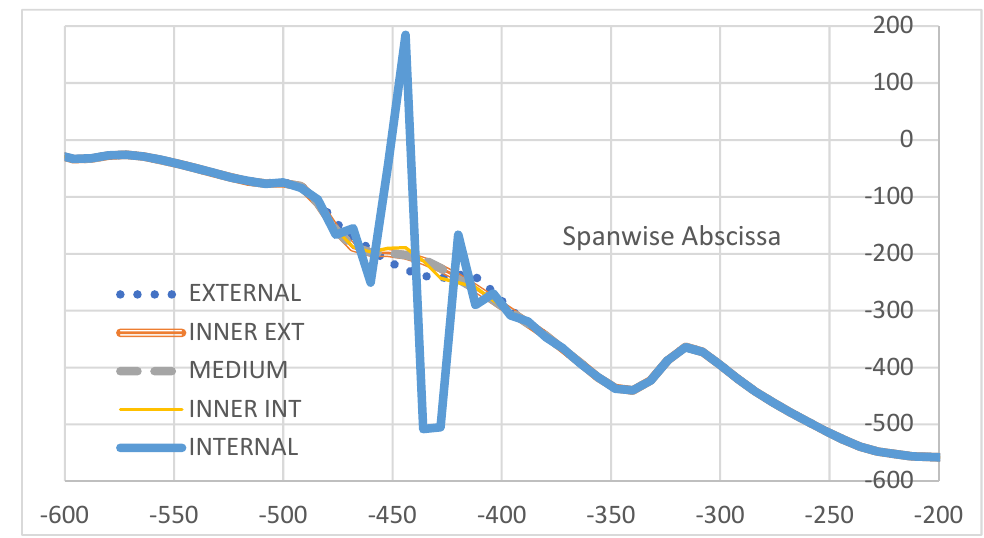
Figure 29. Strain values in the region of local adhesive imperfections placed at different stations along a C-spar top cap, as measured by optical fibers deployed at the inner part of the cap itself, within the bonding layer.